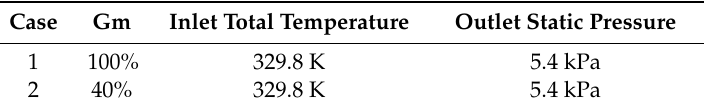
Figure 6. Fluid domain: ( a ) inlet, outlet, and wall, and ( b ) rotationally periodic. Table 4. Boundary